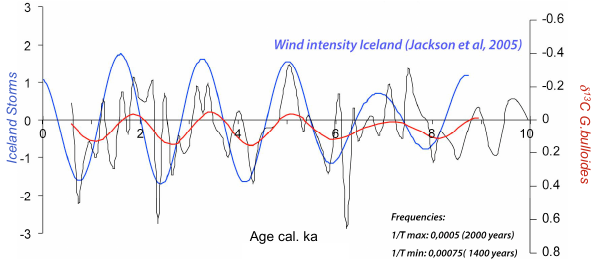
Fig. 8. Comparison of millennial-scale evolution of the 1670-yr cy- cles between storm episodes in Iceland (blue line; Jackson et al., 2005) and the G. bulloides δ 13 C record in the South Adriatic Sea, showing the raw data (black line) and low-frequency band pass (red